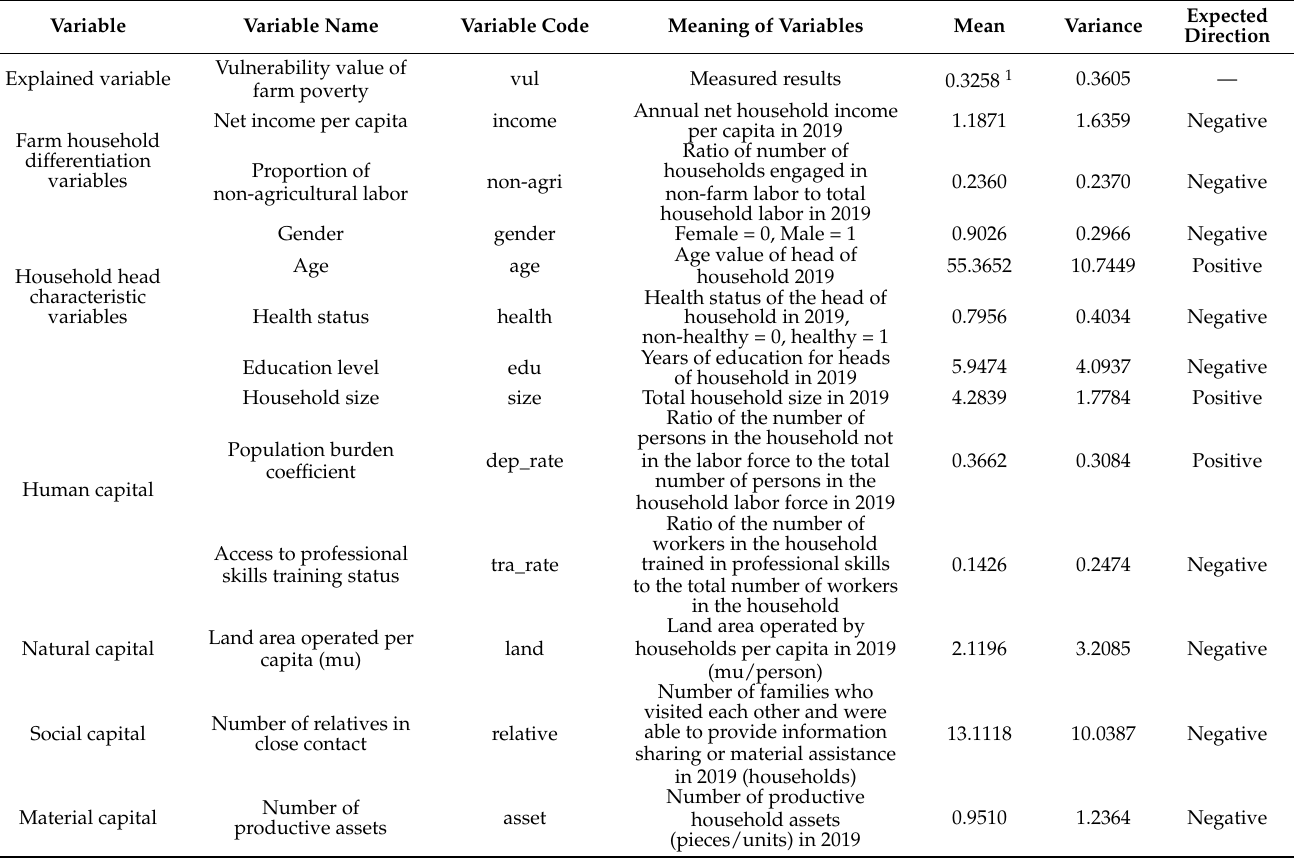
Table 1. Variable definitions, descriptive statistics, and expected direction of